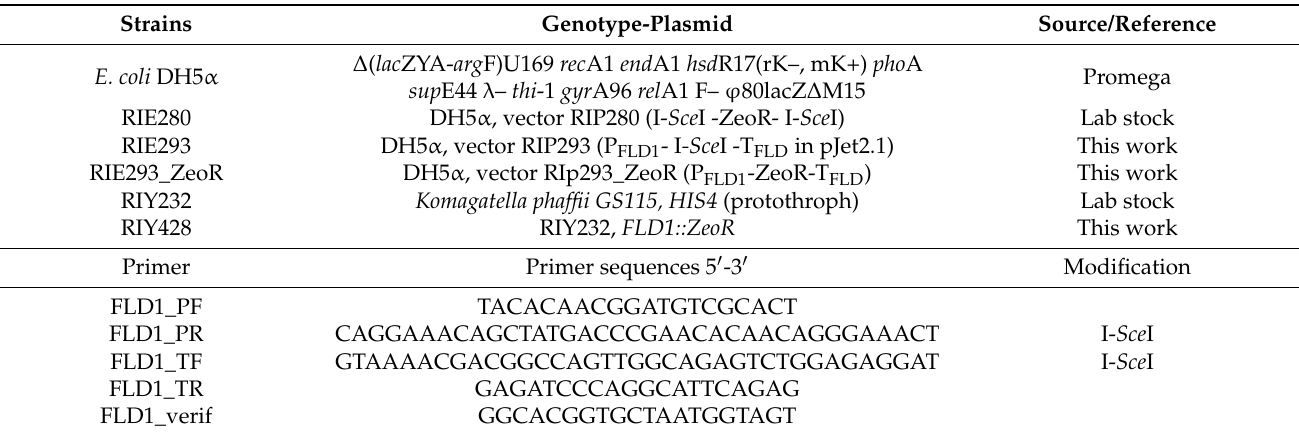
Table 1. Plasmids primer and strains used in this study.